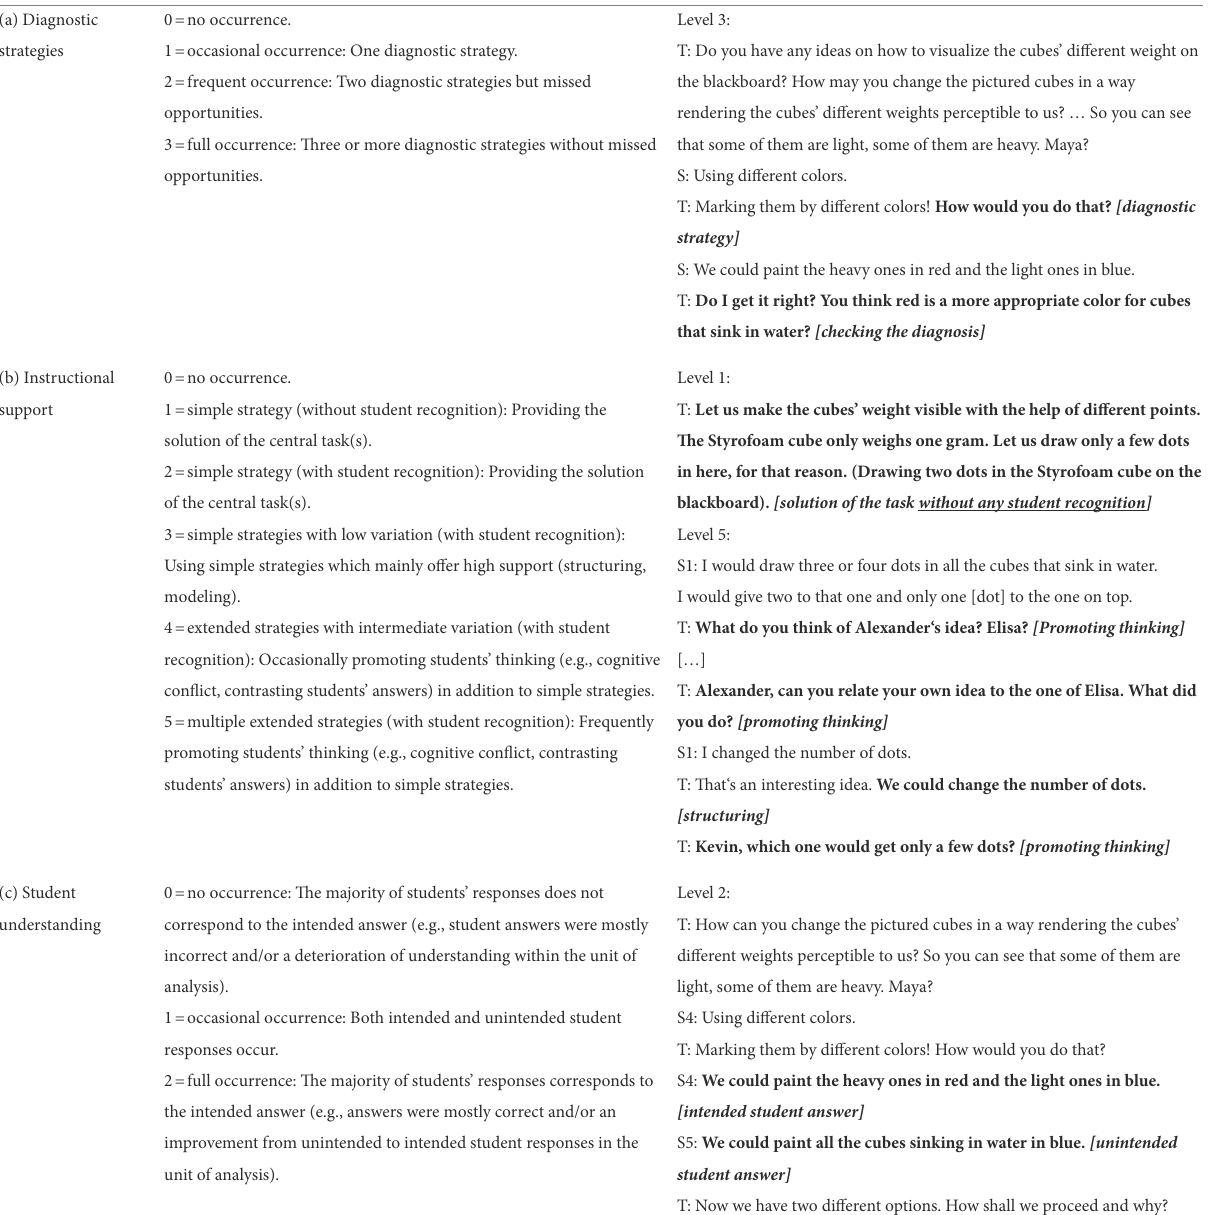
TABLE 1 Coding scheme of adaptive classroom